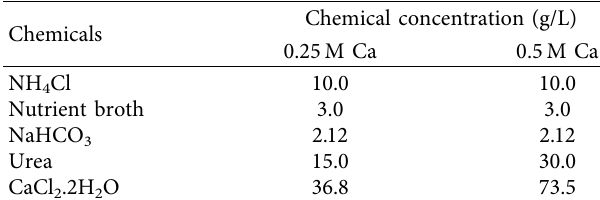
Table 1: Chemical compositions for cementation media.